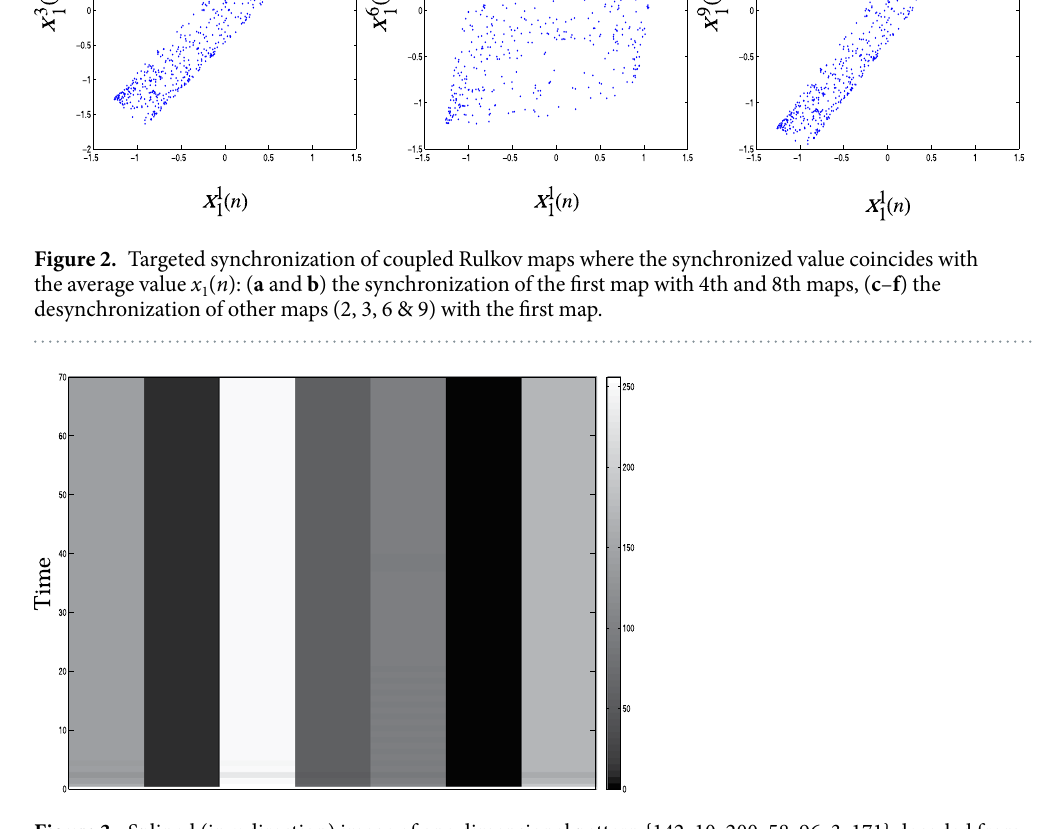
Figure 3. Splined (in x direction) image of one dimensional pattern {142, 10, 200, 58, 96, 3, 171} decoded from the globally coupled Rulkov maps with α = 3.5, β = 0.0005, σ = 0.001 and N =